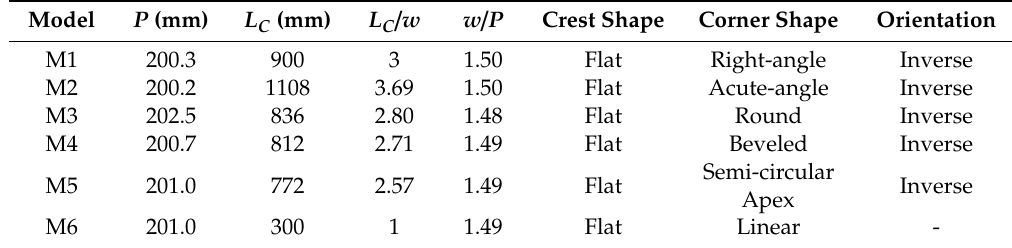
Table 1. Characteristics of the weir models.